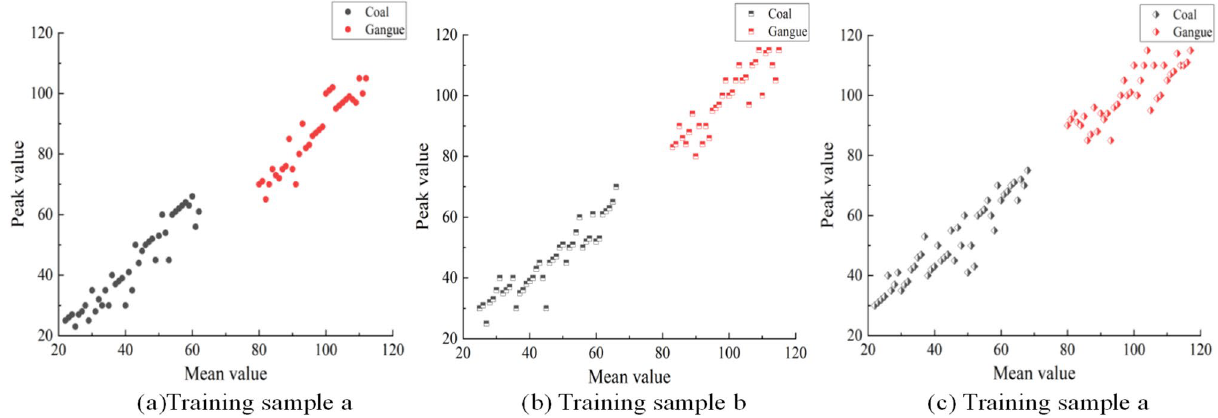
Figure 12. Gray feature classification view of coal and gangue.